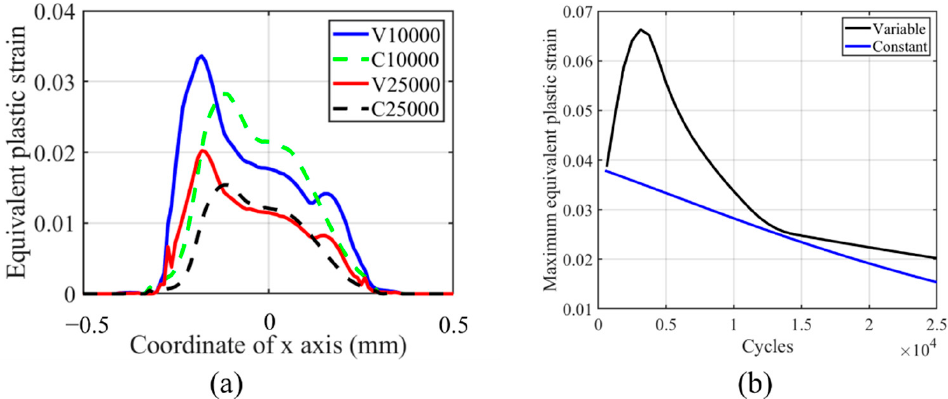
Figure 20. Profile and history of the equivalent plastic strain for the cylindrical pad in the gross sliding regime for both CWCM and VWCM when δ = 50 mm: ( a ) is the profiles in 10,000th cycle and 250,000th cycle, and ( b ) is the maximum value history.